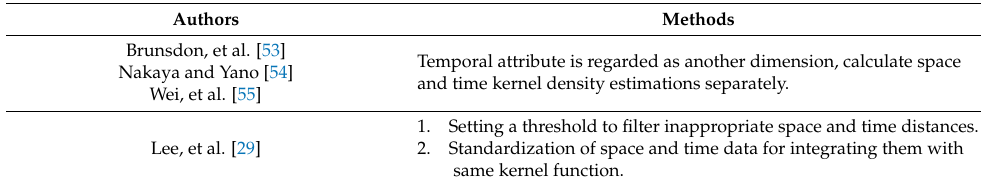
Table 1. Comparison of different extension